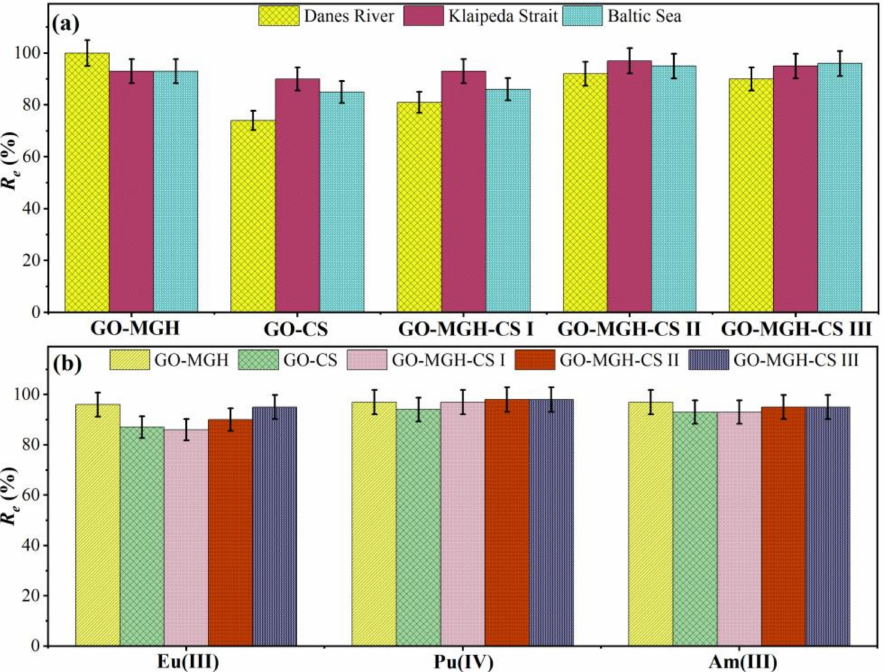
Figure 9. Removal of Eu(III) from different types of natural waters ( a ) and comparison of adsorption efficiency of the composites for Eu(III), Pu(IV), and Am(III) in seawater samples ( b